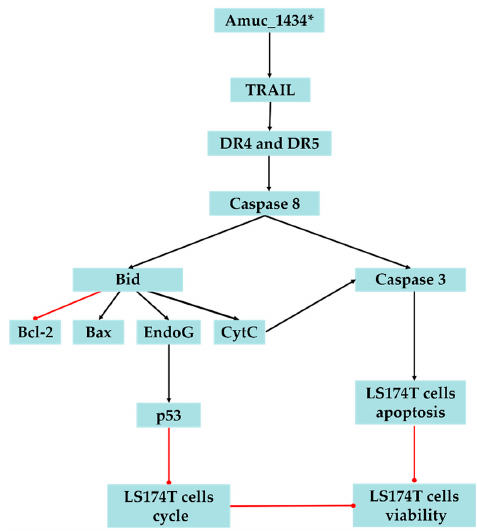
Figure 6. Proposed model of Amuc_1434* effects on LS174T cells. The black lines represent facilitation and the red lines represent inhibition.